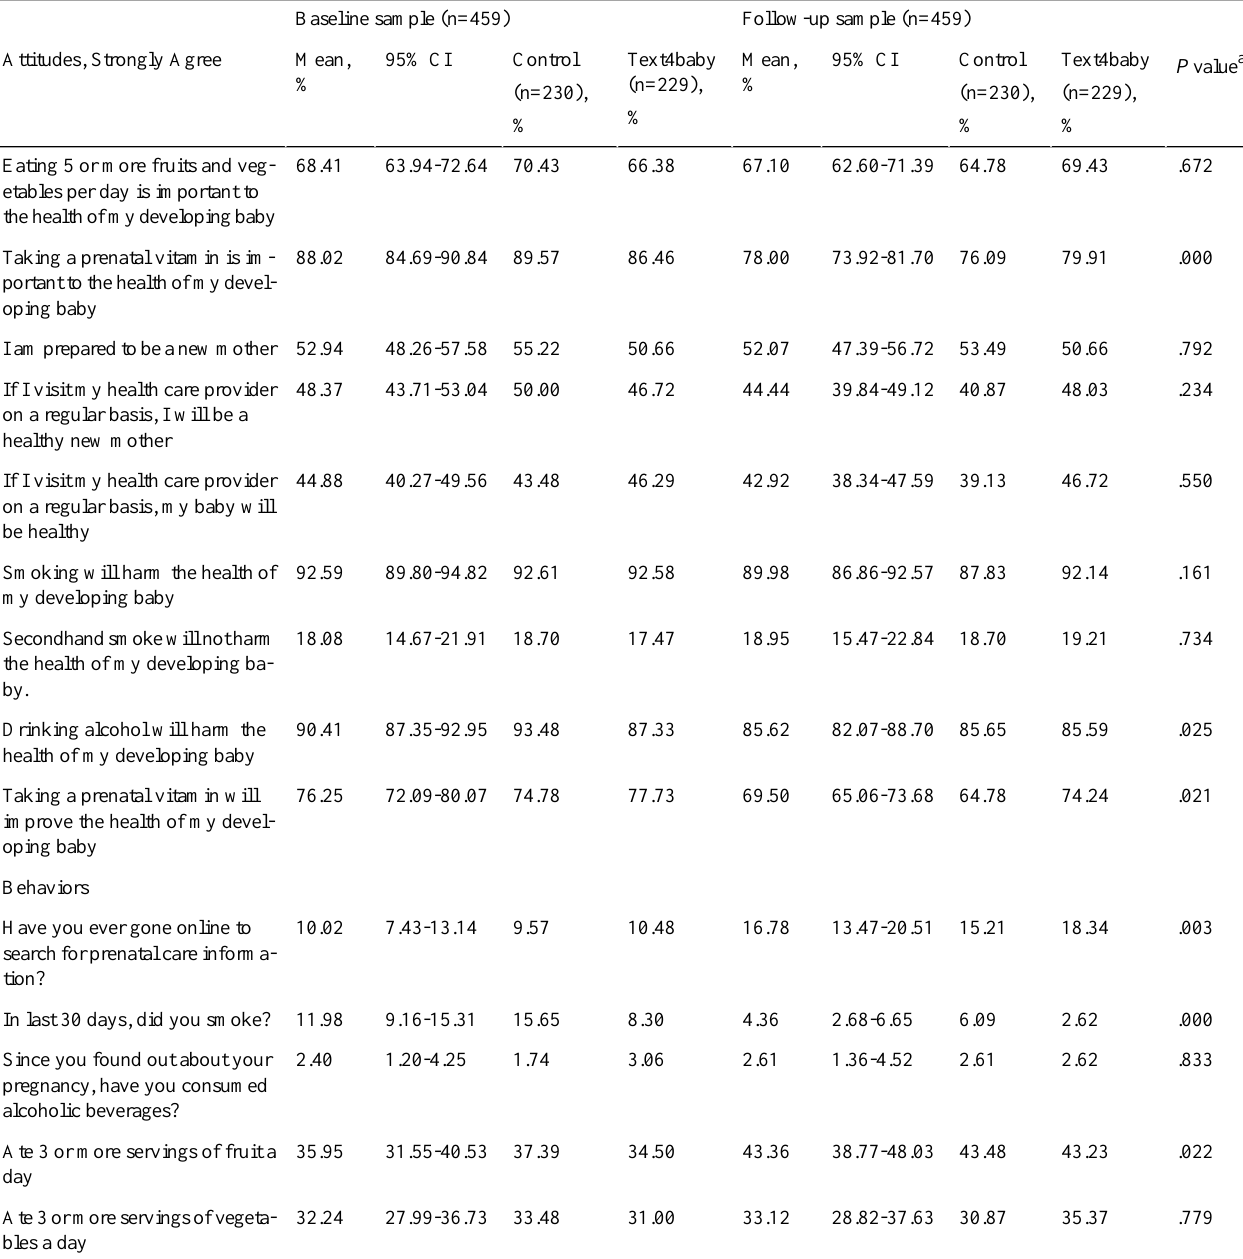
Table 2. Bivariate pre-post comparison of measured outcome variables by treatment group.